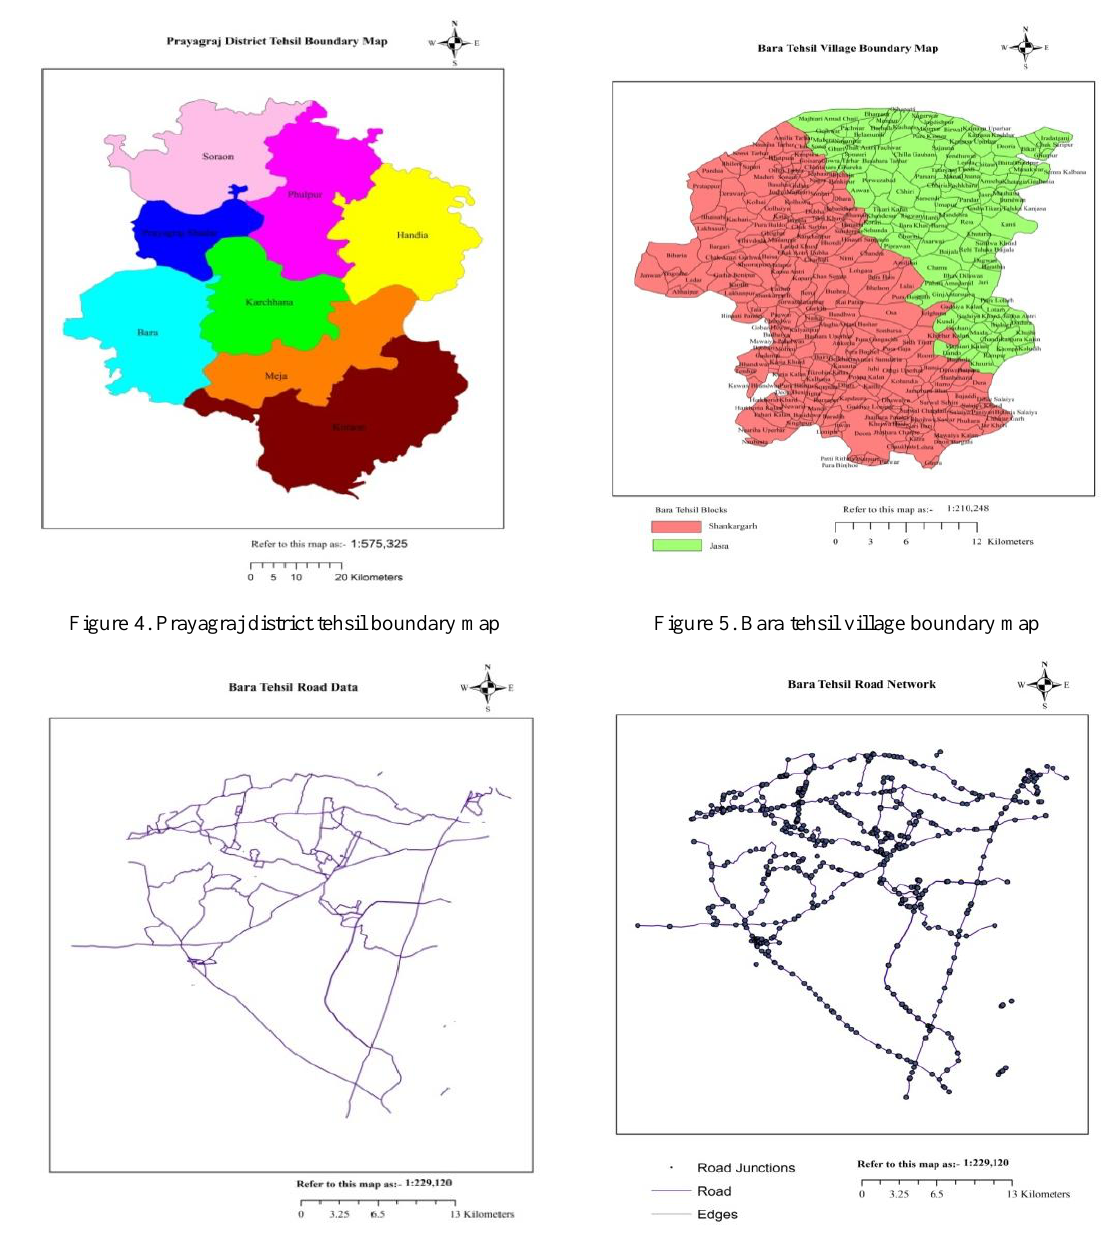
Figure 6. Bara tehsil road map Figure 7. Bara tehsil road network